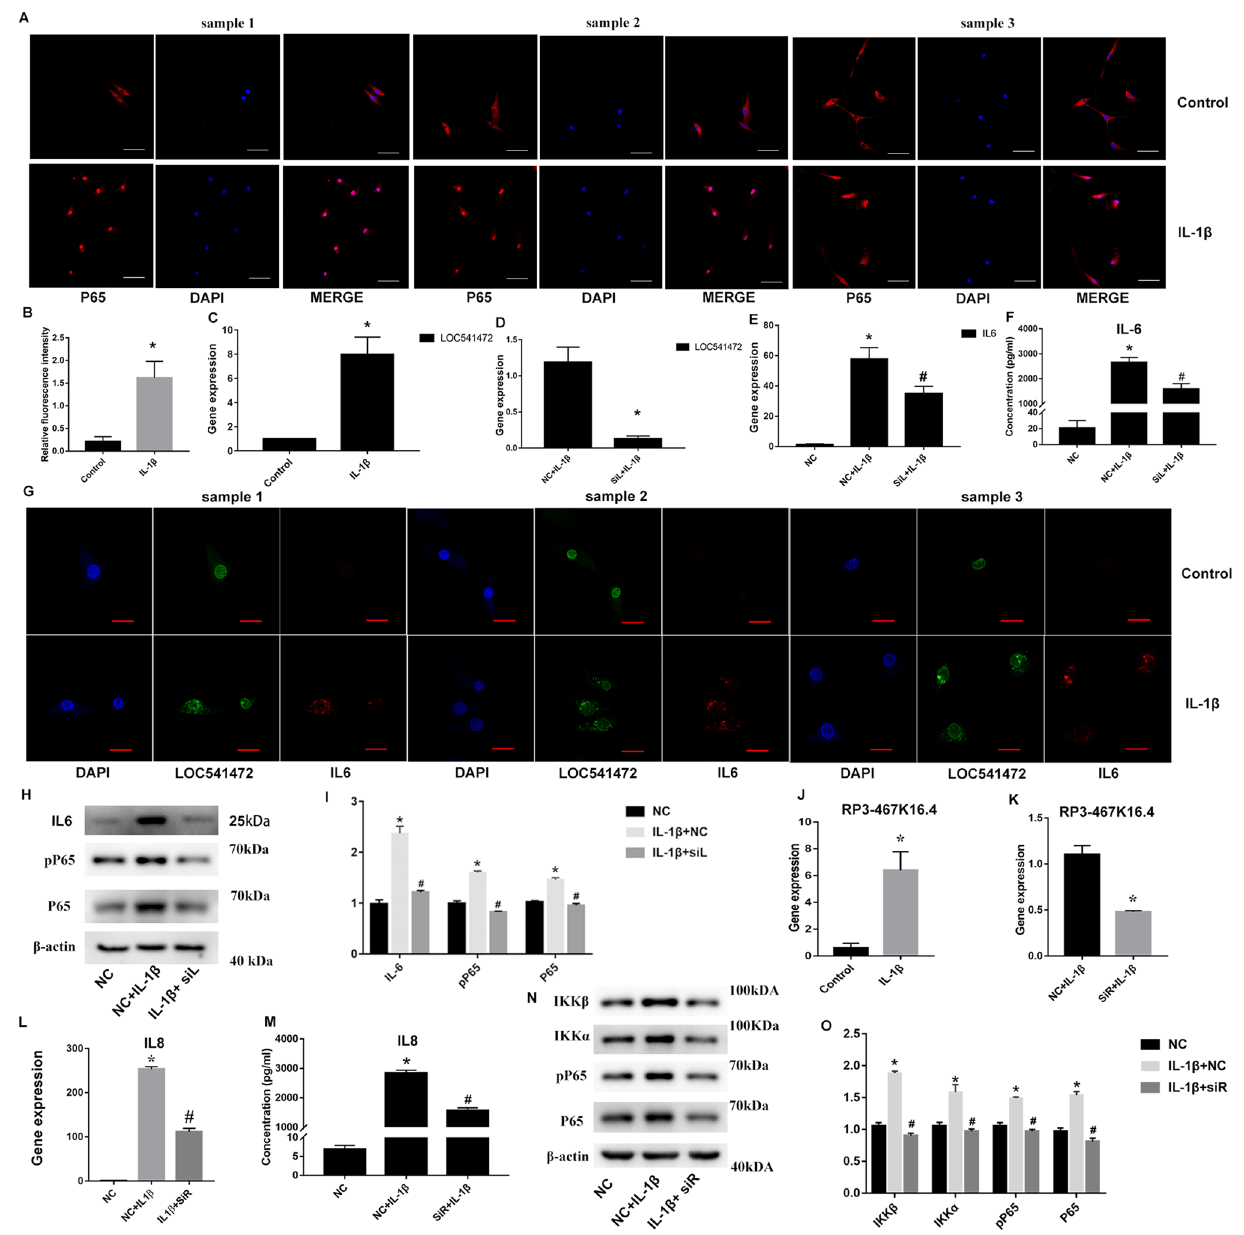
Figure 7. Validation of microarray data. ( A ) Cellular localization of p65 determined by immunofluorescence. ( B ) Semiquantitative analysis of immunofluorescence intensity of p65 in nucleus. ( C ) Expression of the lncRNA LOC541472 in SFMSCs 2 h after stimulation with 10 ng/mL IL ‐ 1β. ( D ) The efficiency of LOC541472 knockdown using Smart Silencer was confirmed by RT ‐ qPCR. IL ‐ 6 gene expression was determined by RT ‐ qPCR ( E ), and IL-6 protein levels were determined by CBA assays ( F ). ( G ) Cellular localization and expression of IL6 and LOC541472 , as demonstrated by RNAscope assays. ( H ) Western blotting of IL6, phosphor-p65, p65, and β-actin. ( I ) Quantification of the blots shown in ( H ). ( J ) Gene expression of the lncRNA RP3-467K16.4 after stimulation with 10 ng/mL IL ‐ 1β for 2 h. ( K ) The efficiency of RP3-467K16.4 knockdown using Smart Silencer was confirmed by RT ‐ qPCR. SFMSCs were transfected with Smart Silencer targeting RP3-467K16.4 for 48 h and then incubated with 10 ng/mL IL ‐ 1β for 2 h, and expression of the IL8 gene was measured by RT ‐ qPCR ( L ), and IL8 protein levels were determined by CBA assays ( M ). ( N ) Western blotting of IKKβ, IKKα, phosphor-p65, p65, and β-actin. ( O ) Quantification of the blots shown in ( M ). NC negative control, SiL Smart Silencer targeting LOC541472 , SiR Smart Silencer targeting RP3-467K16.4 , pP65 phospho p65. * P < 0.05 vs. negative control or control group. # P < 0.05 vs. NC + IL ‐ 1β group. N = 3. Scale bars = 100